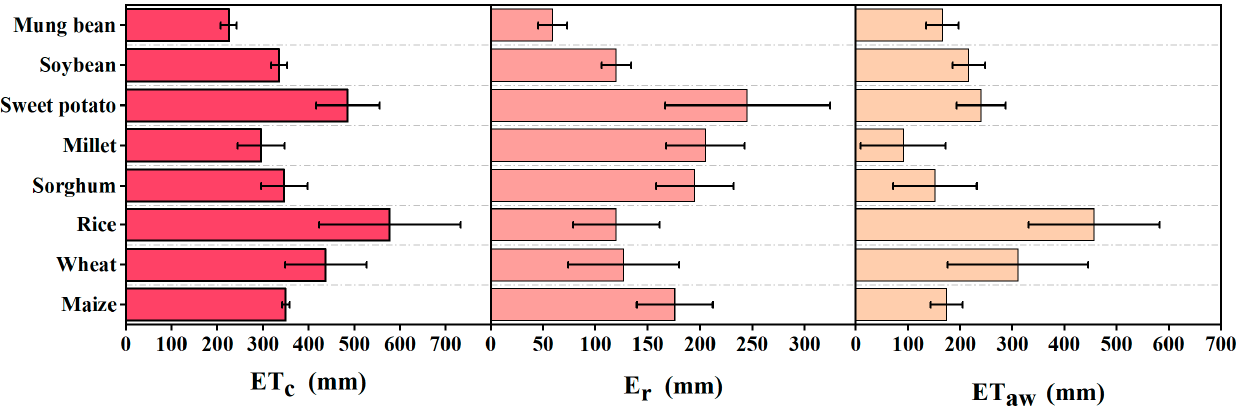
Figure 3. Water requirement ( ET c ), effective rainfall ( E r ), and irrigation requirement ( ET aw ) of different tested crops under traditional cultivation in Huang-Huai-Hai farming region. The bar and whisker are the average value and standard deviation of each indicator for each crop across all the investigated sites, respectively.